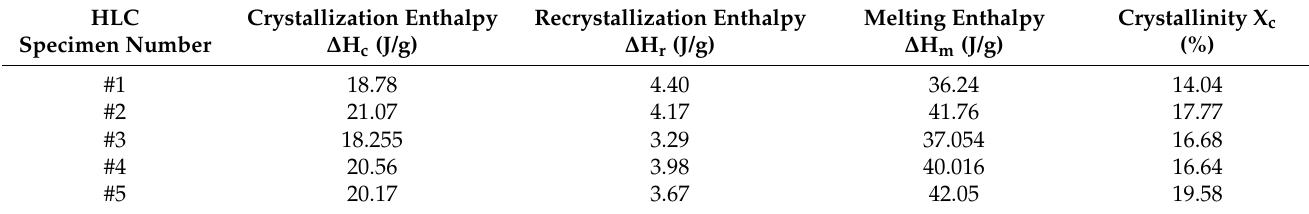
Table 4. Crystallinity contents reported for the five HLC